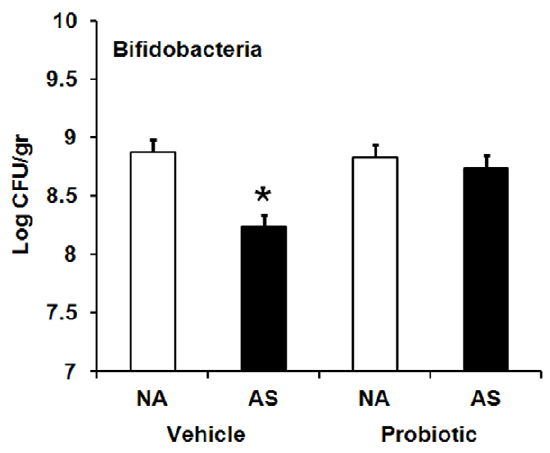
Figure 9. Effect of maternal probiotic intake and adult stress on bifidobacteria. Effect of maternal probiotic intake and adult restraint stress (AS) on faecal counts of bifidobacteria (Log CFU/gr, least squares means + SE) in Wistar rats at week 12. Hollow bars represent animals exposed to no adult stress (NA): NA vehicle (n=33), NA probiotic (n=35). Filled bars represent animals exposed to adult stress (AS): AS vehicle (n=39), AS probiotic (n=36). An asterisk (*) shows significant difference compared to non-stressed (NA) animals in the vehicle subset ( p # 0.05).